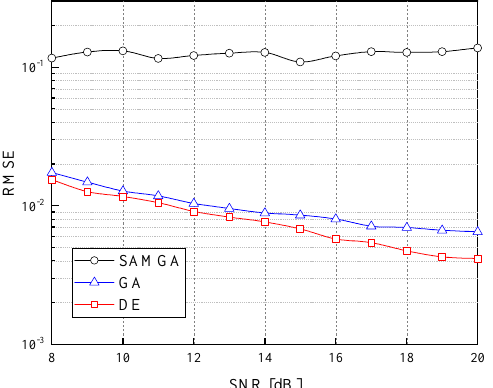
Figure 4. Performances of three estimators on the improved model with CFO values varying as a sinusoidal